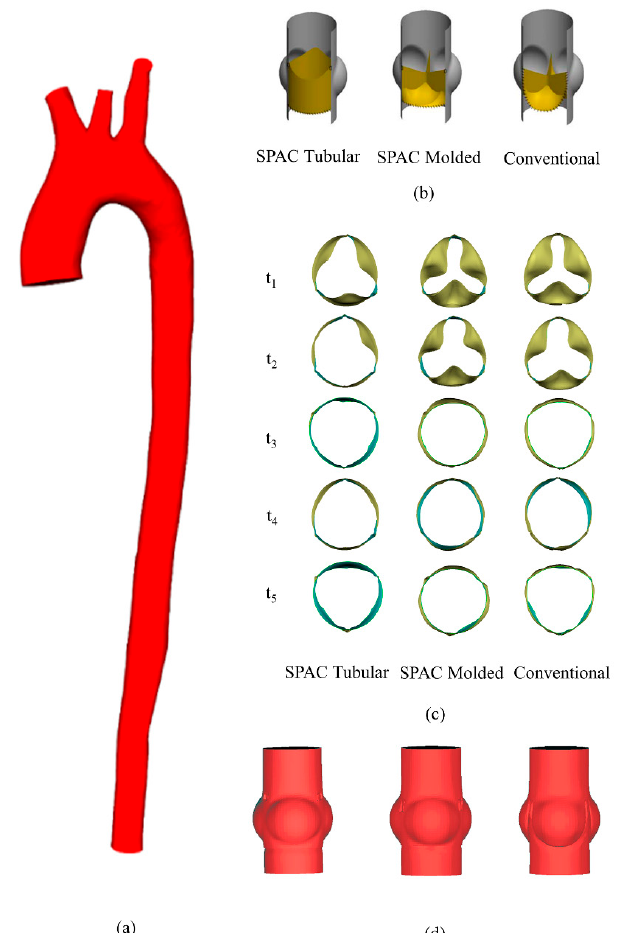
Figure 1. ( a ) The reconstructed 3D patient-specific aorta model; ( b ) schematic representation of di ff erent leaflet designs and implant approaches; ( c ) the deformed geometric configurations of three valves at five di ff erent time points; ( d ) the diagram of aortic roots with virtually implanted